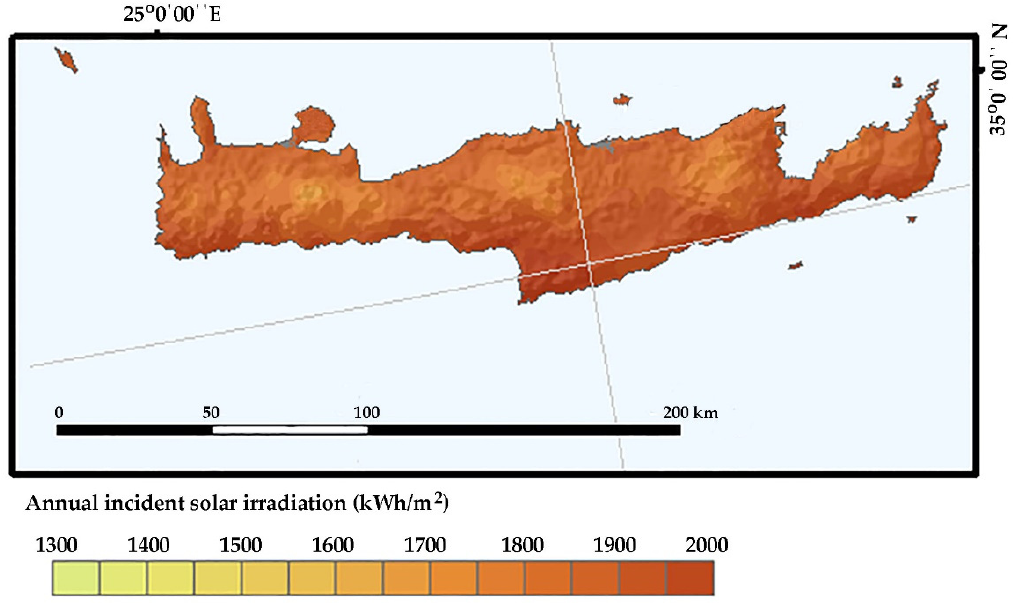
Figure 22. Annual average of global horizontal solar irradiation fluctuation in Crete Island [100].